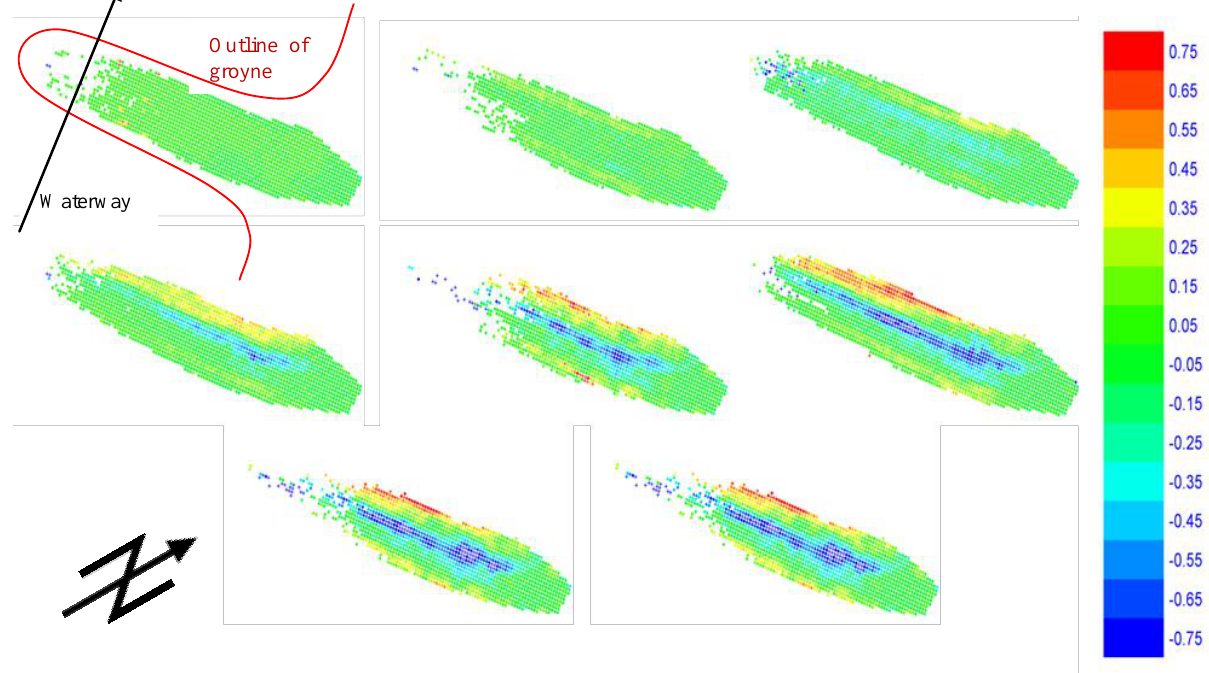
Figure 9. Visualisation of gridded deformation [m] from left to right and top to bottom. Epoch interval is about 1 month starting with the measurement of the reference epoch till 7 month